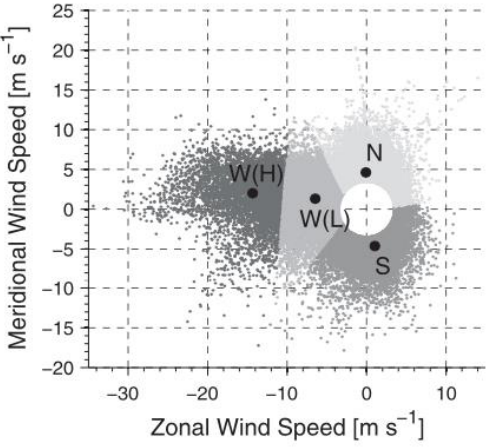
Figure 19. Optimal wind clusters at 80 m at the NWTC near Boulder [18].